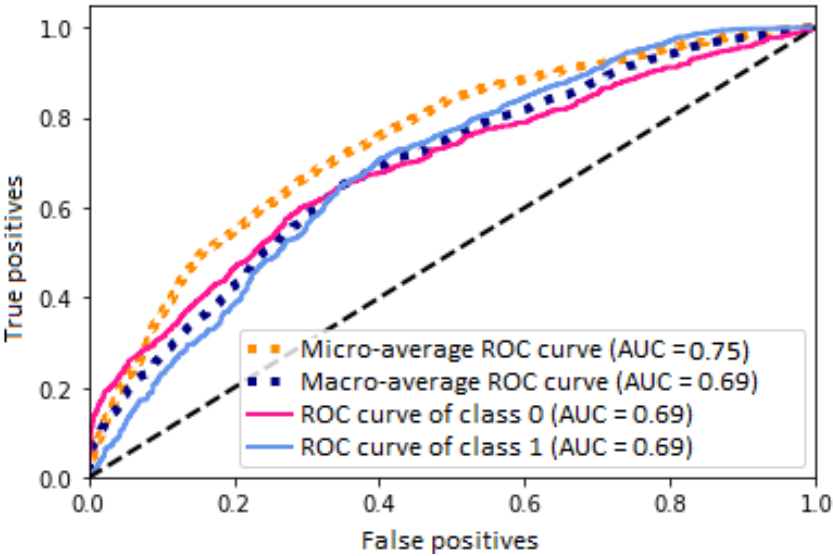
Figure 7. Graph of the ROC curves generated based on the average performance of the ANN in the classification of